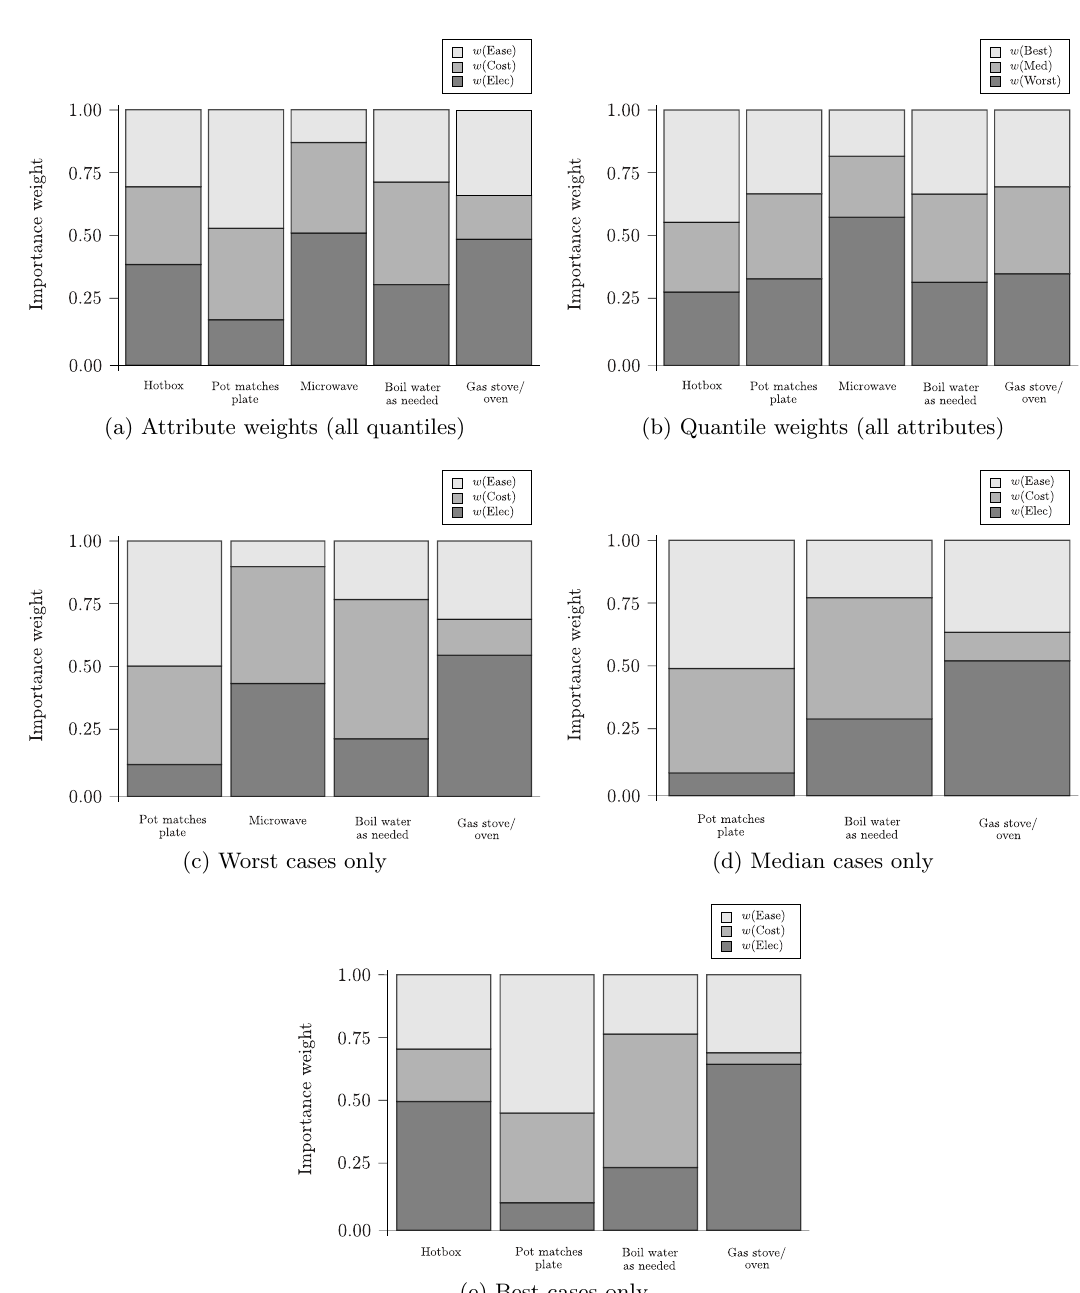
Central weight vectors for electricity savings options obtained with an adapted SMAA-O model. All figures are based upon Model